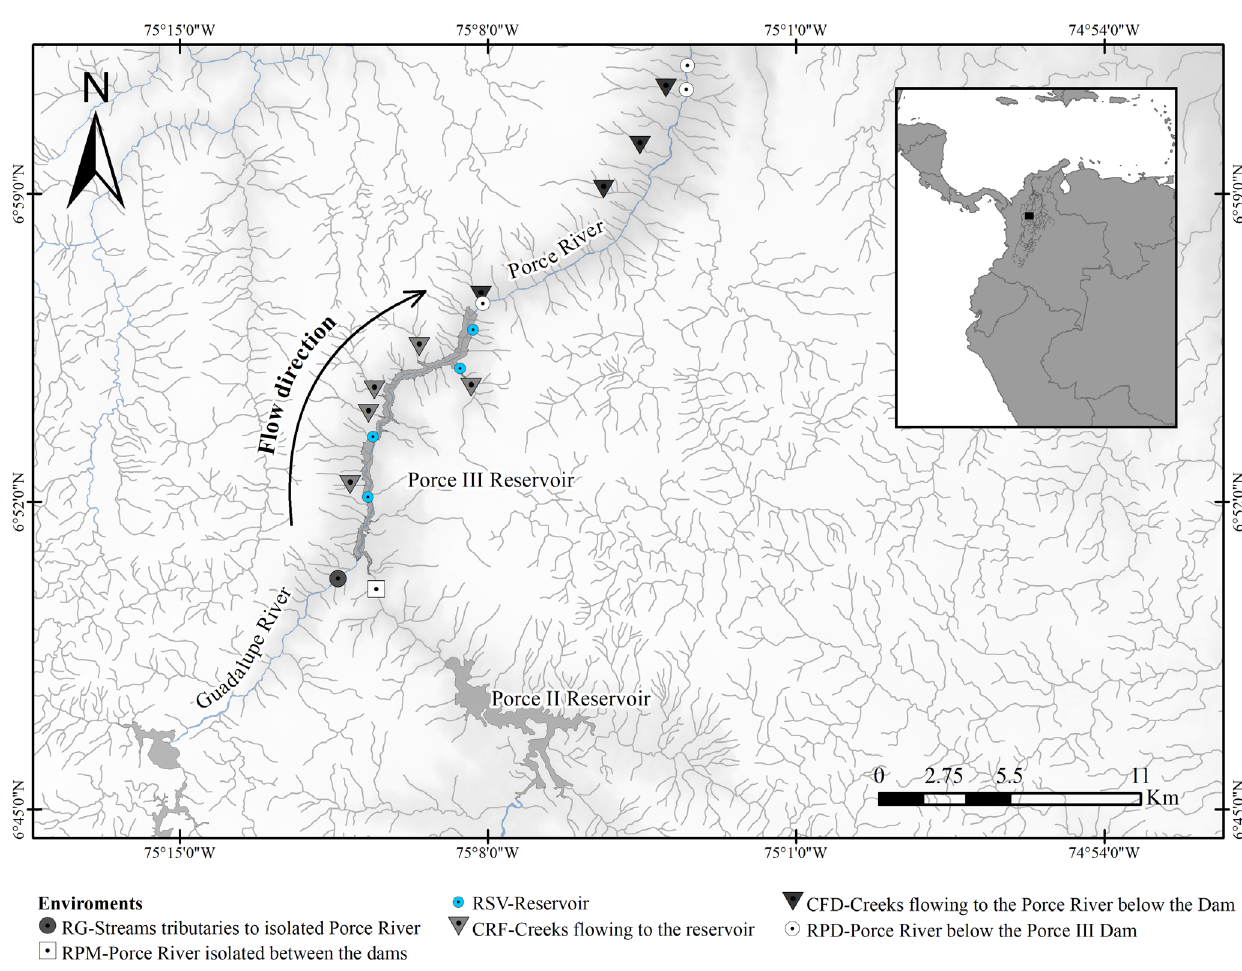
FIGURE 1 | Sampling sites in Porce III reservoir. The digital elevation model (SRTM, 1 arc-second) was obtained from USGS Earth Explorer (https://earthexplorer.usgs.gov) and shape file of dams was obtained from IGAC (https://geoportal.igac.gov.co/). All other products were produced by the authors and are